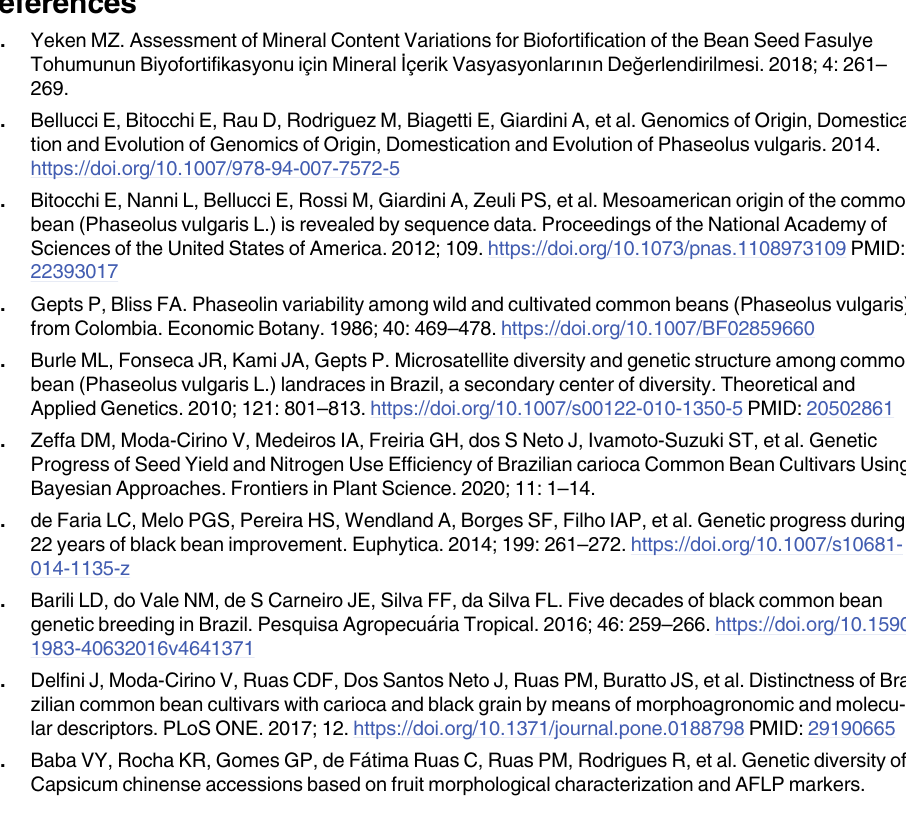
S1 Table. List of accessions constituting the Mesoamerican Panel of Bean Diversity